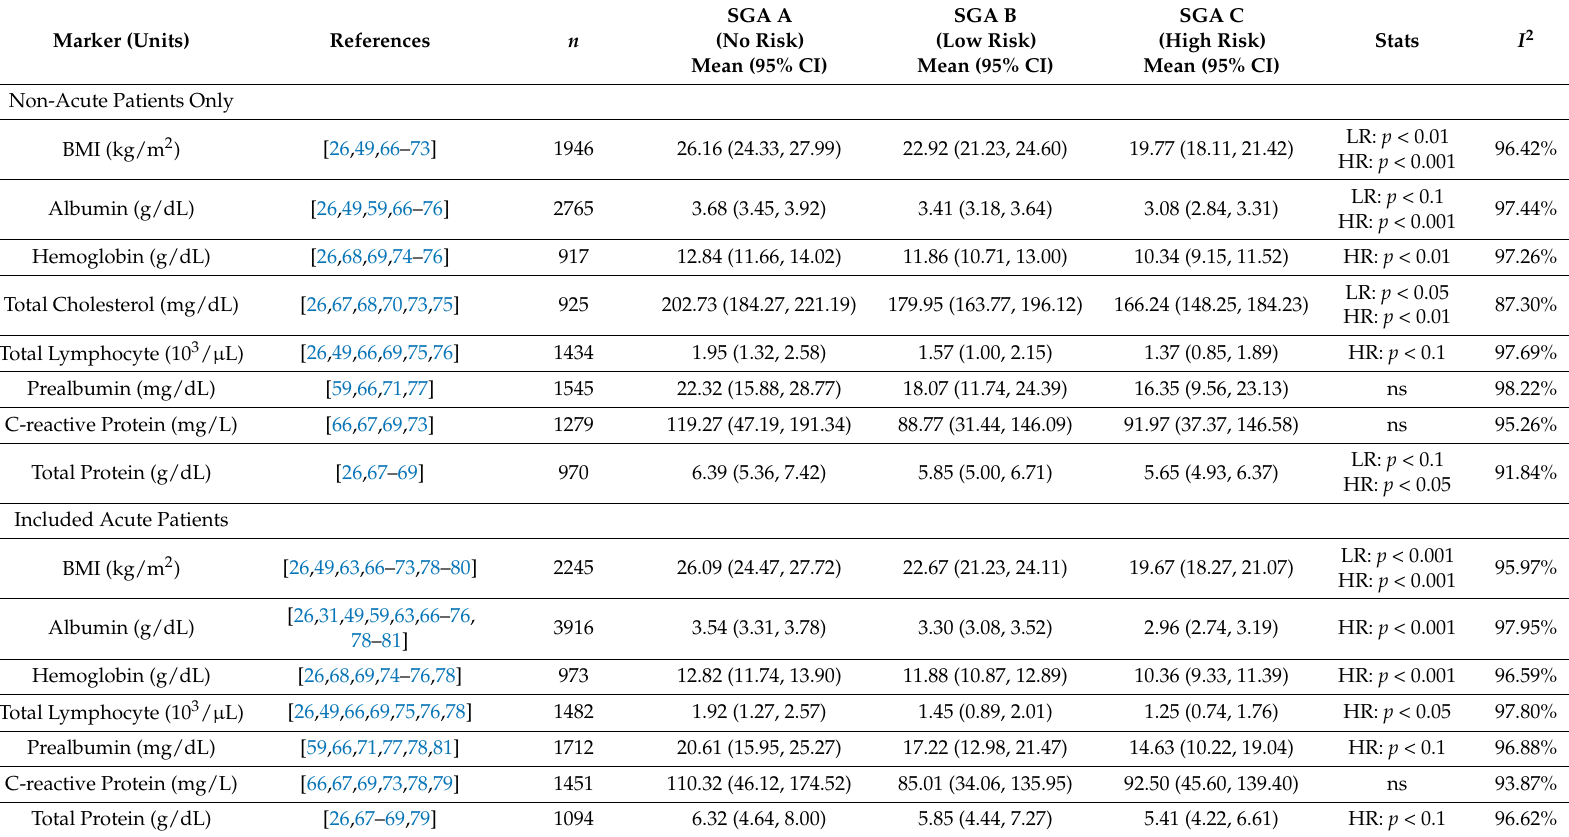
Table 3. Mean biomarker levels in 3 subgroups of malnutrition risk status defined by SGA 1